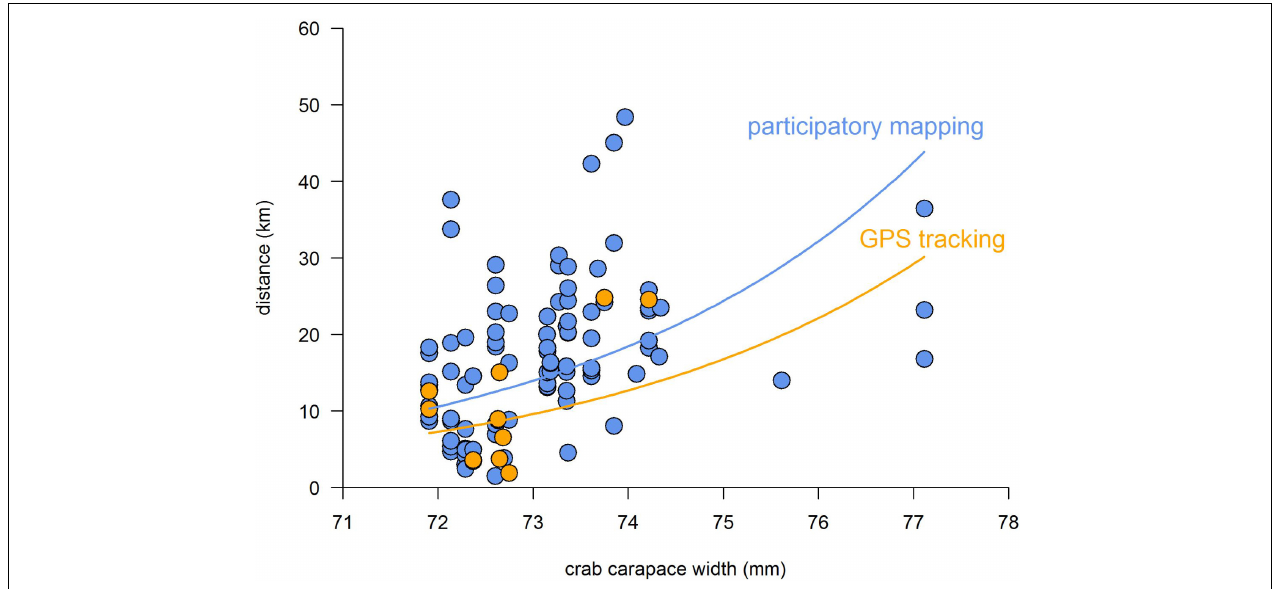
FIGURE 6 | Relationship ( p < 0.001) between crab sizes and distances traveled by fishers recorded via GPS tracking ( n = 11) and participatory mapping ( n = 92), with no significant difference between the two methods ( p = 0.07).